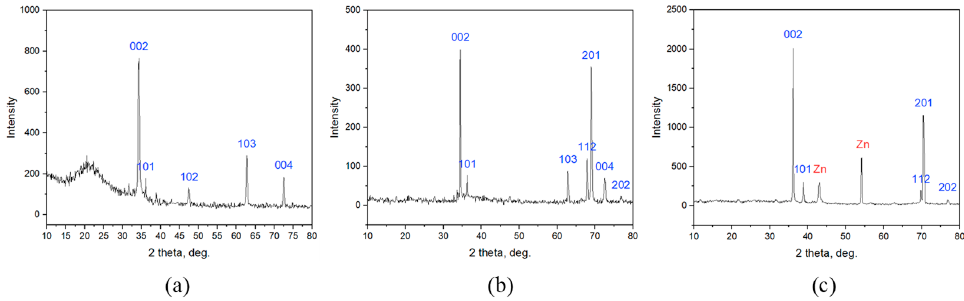
Figure 5. The XRD analysis results for the ZnO structures obtained by the PECVD method at the various zinc source temperatures: ( a ) 370 °C; ( b ) 420 °C; ( c ) 470 °C.